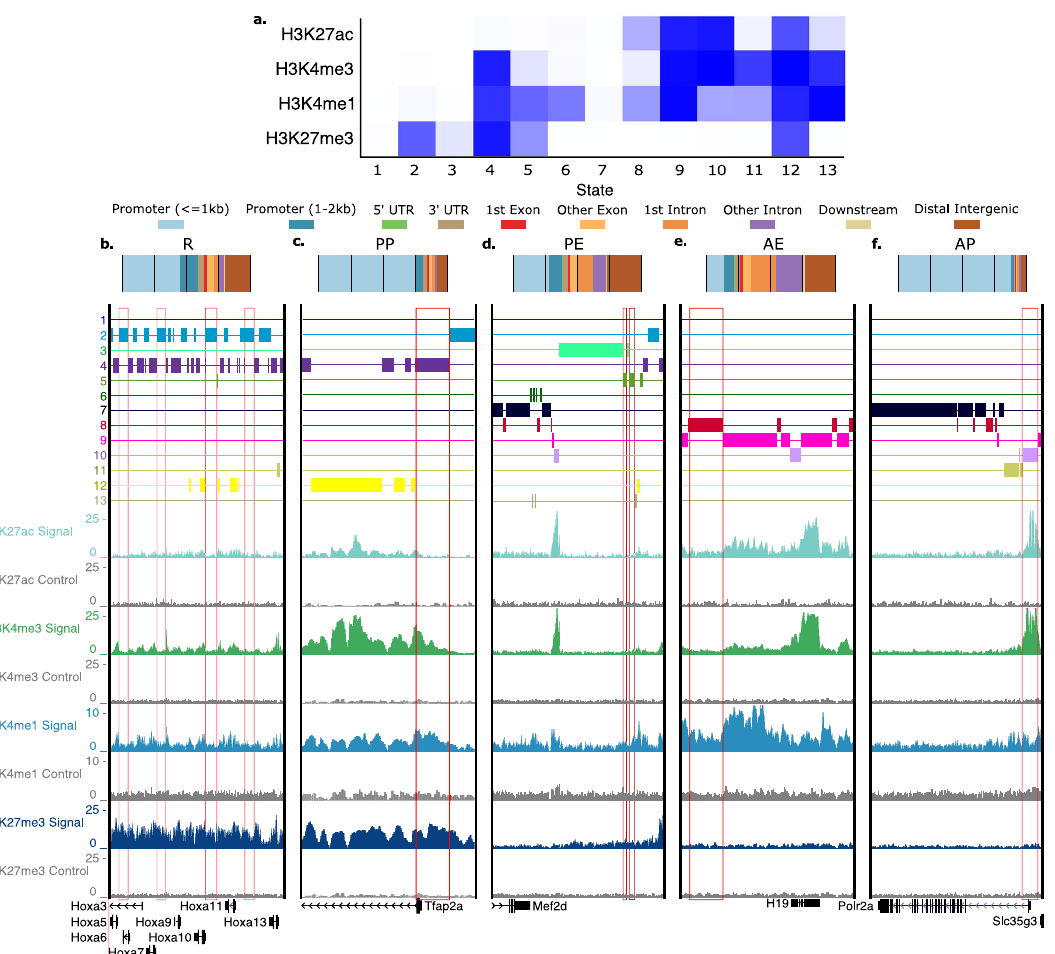
Figure 1. ChromHMM defined chromatin states in e9.5 mouse placenta. ( a ) ChromHMM heatmap displaying the amount of activity of each histone modification in the identified states. ( b – f ) Top: Genomic feature locations of regions within each identified state. Bottom: UCSC Genome Browser view showing example(s) of genomic region(s) (red box(es)) associated with each state. ( b ) State 2—repressed (R) ( c ) State 4—poised promoter (PP) ( d ) State 5—poised enhancer (PE) ( e ) State 8—active enhancer (AE) ( f ) State 10—active promoter (AP). Control signal tracks are for input